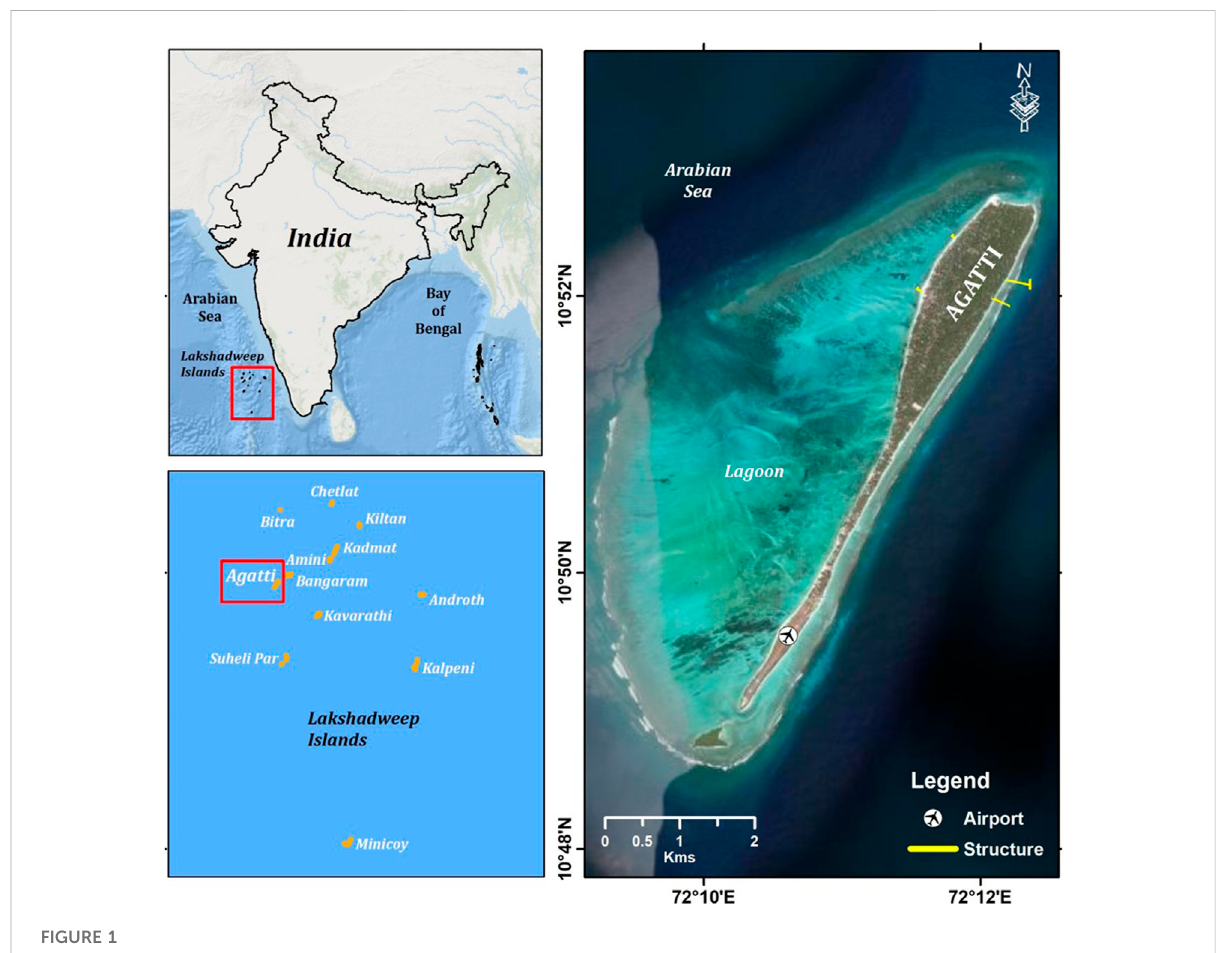
FIGURE 1 Map showing study